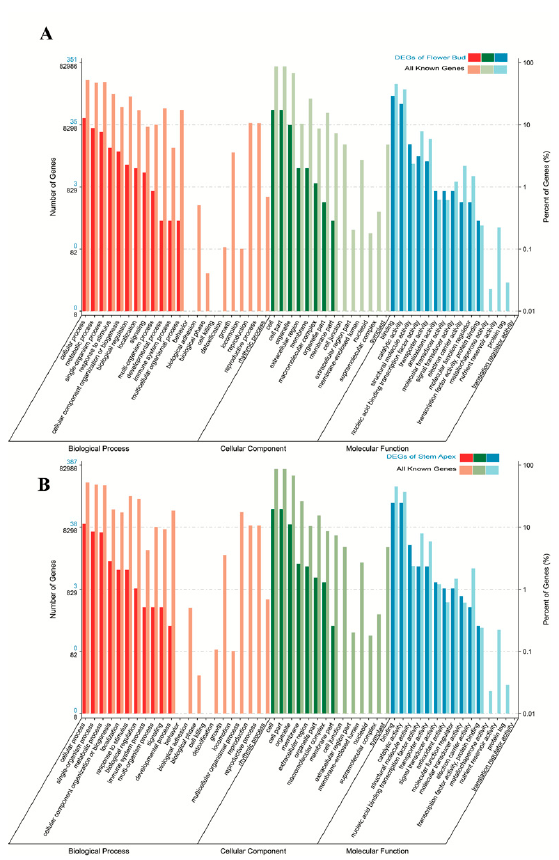
Figure 3. Gene ontology (GO) annotation analyses of DEGs identified at flower bud ( A ) and stem apex ( B ). Significantly, DEG distributions of the cellular component, molecular function, and biological process are almost consistent at the flower bud and stem apex.